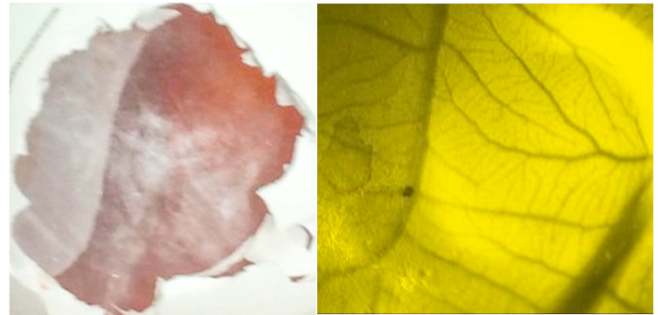
Figure 5. Macroscopic and microscopic images of normal chorioallantoic membrane (CAM) after inoculation with C- Φ KAZ14 NP and incubation for 24 h. No signs of toxicity were observed on the CAM surface. The embryo survived after 24 h of incubation.